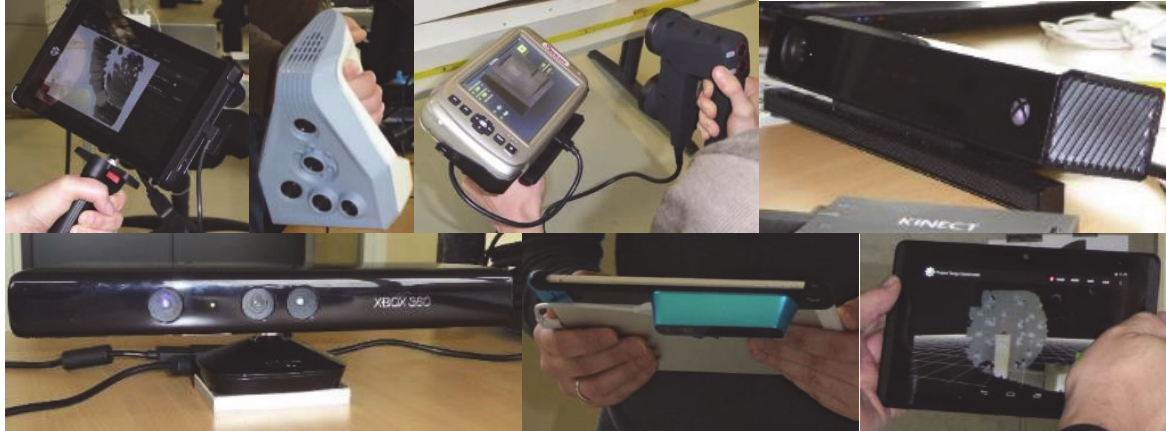
Figure 2. Examined hand-held scanner system (f.l.t.r.) – DPI-7, Artec Spider, Mantis Vision F5, Kinect v2 (top),